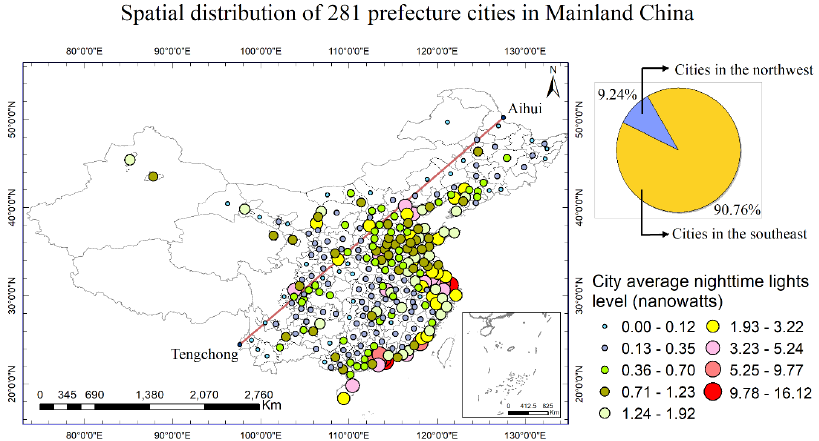
Figure 1. The selected 281 prefecture cities in Mainland China (Note: they are unevenly separated by the Aihui-Tengchong Line, which indicates the unbalanced distribution of the population).